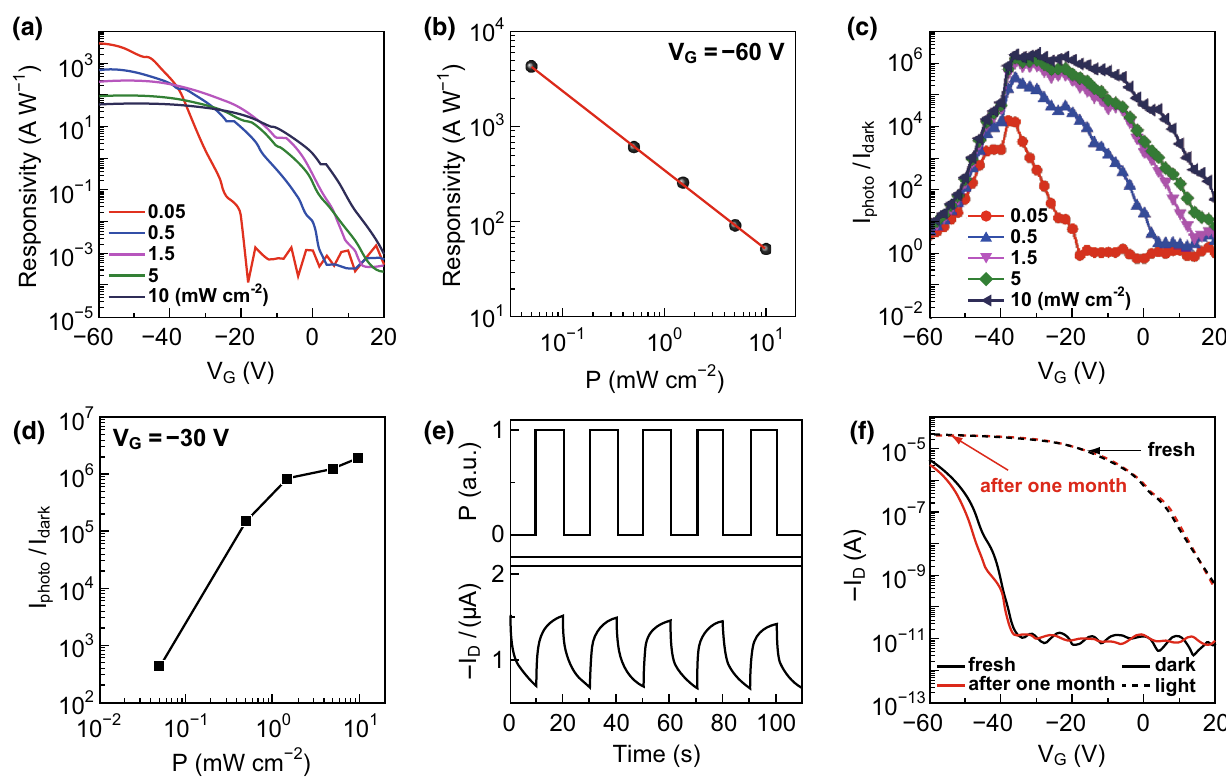
Fig. 4 a Responsivity of the hybrid phototransistor as a function of the gate voltage for different illumination power densities. b Illumination power density dependence of the responsivity at V G = - 60 V, V D = - 30 V. c I photo / I dark ratio as a function of the gate voltage for different illumination power densities. d Illumination-power-density dependence of the I photo / I dark ratio at V G = - 60 V, V D = - 30 V. e Photoswitching characteristics of the hybrid phototransistor under an alternating dark and light illumination (0.5 mW cm - 2 ) at V G = - 30 V, V D = - 30 V. f Transfer curves of the fresh hybrid phototransistor and device stored at an atmospheric environment (average temperature of 0 (cid:3) C and average relative humidity of 50%) for 1